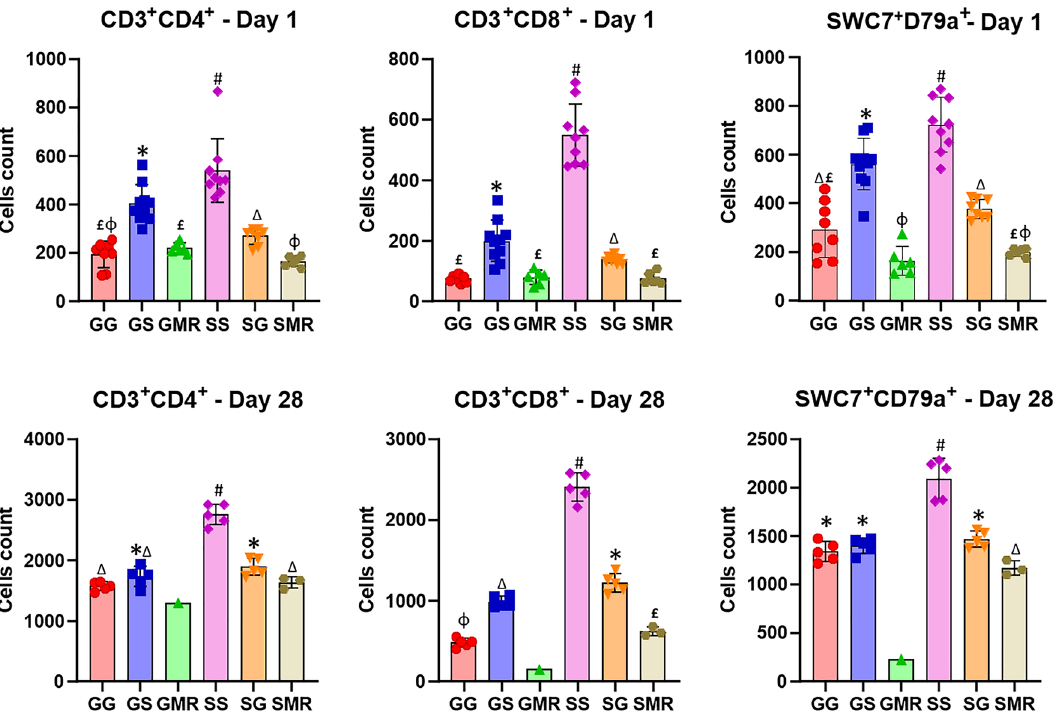
Figure 5. Comparative analysis of CFSE-based lymphocyte proliferation from PBMC in the groups studied. Peripheral blood mononuclear cells were stained with CFSE (1 × 10 6 /mL) and cultured in duplicate. The cells were incubated in a medium alone (nonstimulated-control) and with Concanavalin A (5 µg/mL, stimulated cells). The cells from piglet groups were cultured for 72